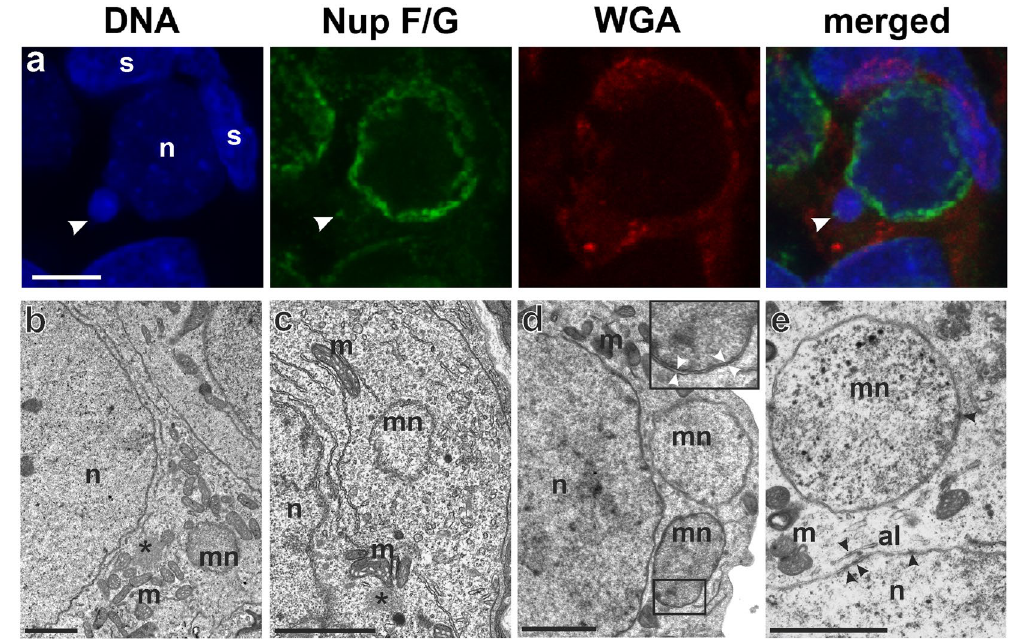
Figure 1. Morphology of the micronuclei in gonocytes of P. esculentus . ( a ) Immunofluorescent staining of frozen tissue sections of testis from male at 28 Gosner stage: cell membrane (wheat germ agglutinin, WGA, red) and nuclear pore complex proteins, NPC (Nup F/G, green), DNA counterstained with DAPI (blue). Confocal image represents projection of 4 z-sections (0.46 µ m thick) to highlight the weak NPC staining at the rim of micronucleus (arrowhead) contained inside the cell boundaries probed with WGA. Note the weaker chromatin signal in nuclei of germ cells (n), corresponding to euchromatin, and stronger signal in nuclei of somatic cells (s), corresponding to heterochromatin. ( b–e ) TEM images of micronuclei present in prespermatogonia ( b,c ) and gonocytes ( d,e ). Micronuclei were found in both diploid ( b,d,e ) and triploid ( c ) hybrids during the premetamorphosis stage of somatic development according to Gosner (1960), stage 36 ( d,e ) or during metamorphosis climax, stage 46 ( b,c ). Double membrane envelope was surrounding chromatin in micronuclei, similarly as in main nuclei (inset in d ). Chromatin condensation level differed from euchromatin ( c–e ) to heterochromatin ( b,d ). Cytoplasm of germ cells was filled with membranes (al), mitochondria and